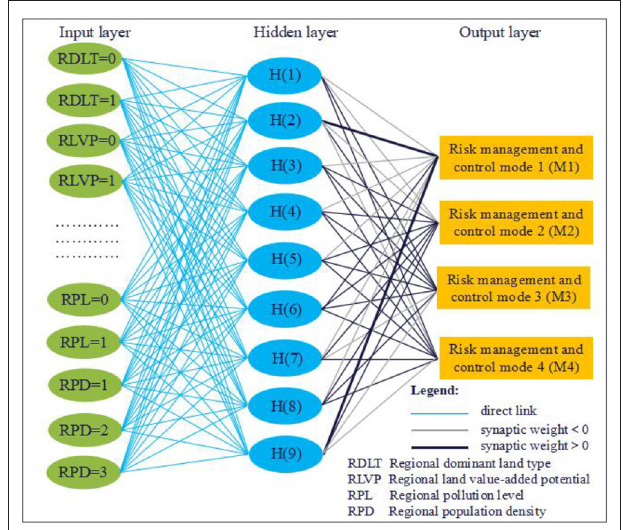
FIGURE 3 | The ANN model based on the BP algorithm.